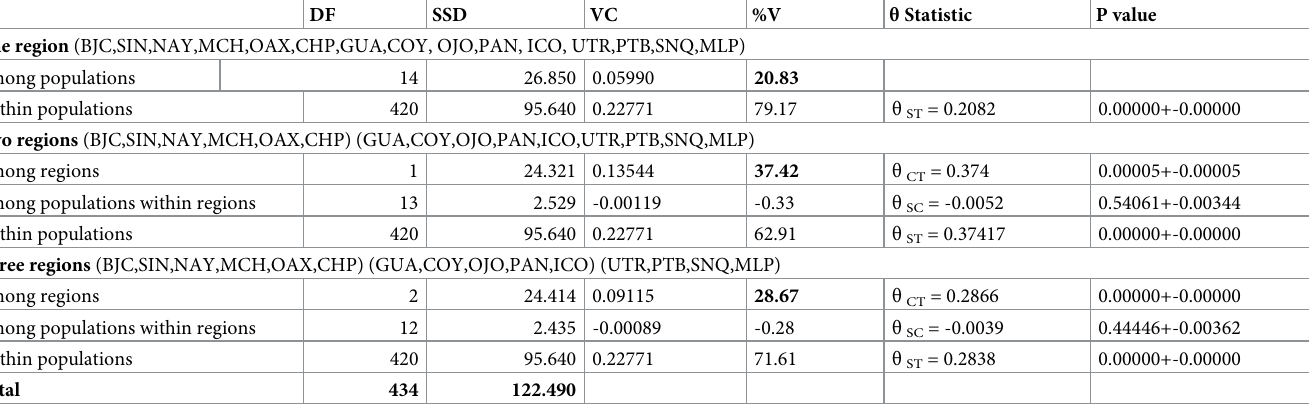
Table 3. Hierarchical Analysis of Molecular Variance (AMOVA) on sequences of the mitochondrial control region for Sphyrna lewini in the Eastern Tropical Pacific.